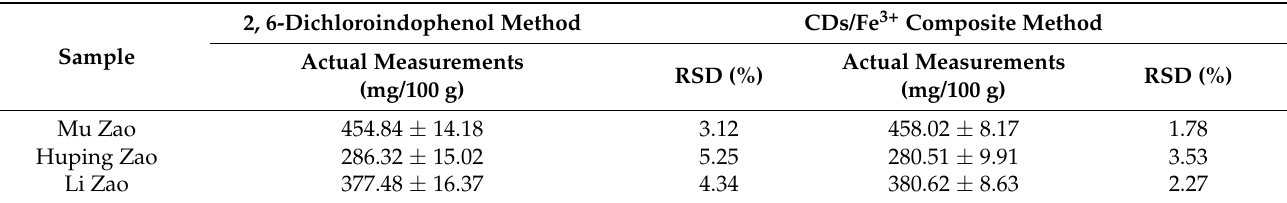
Table 2. Determination results of ascorbic acid in different jujube fruits ( n = 5).